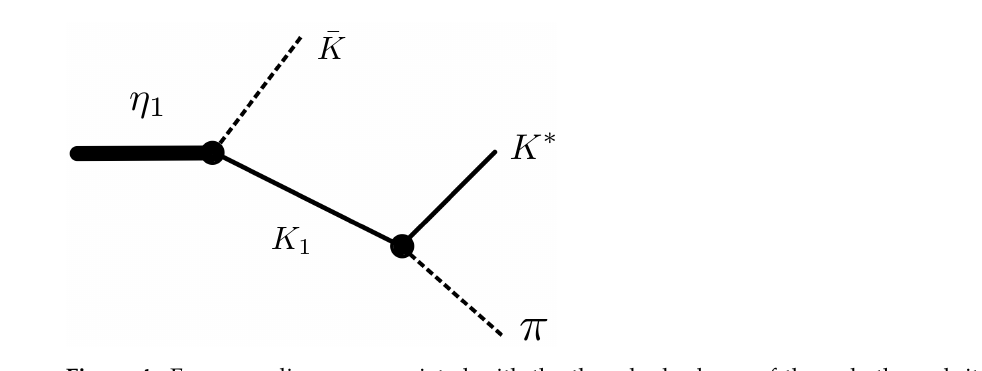
Figure 4. Feynman diagram associated with the three-body decay of the pole through its main component K 1 ¯ K